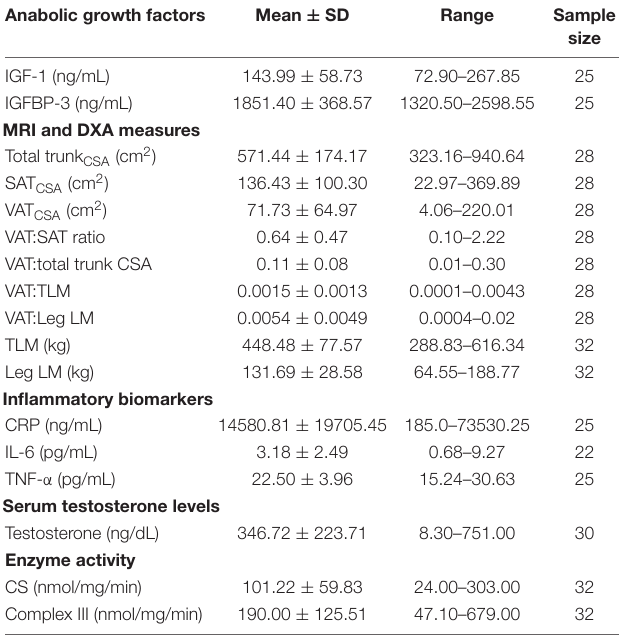
TABLE 2 | Citrate synthase activity, inflammatory biomarkers, anabolic growth factors, and serum testosterone levels. Anabolic growth